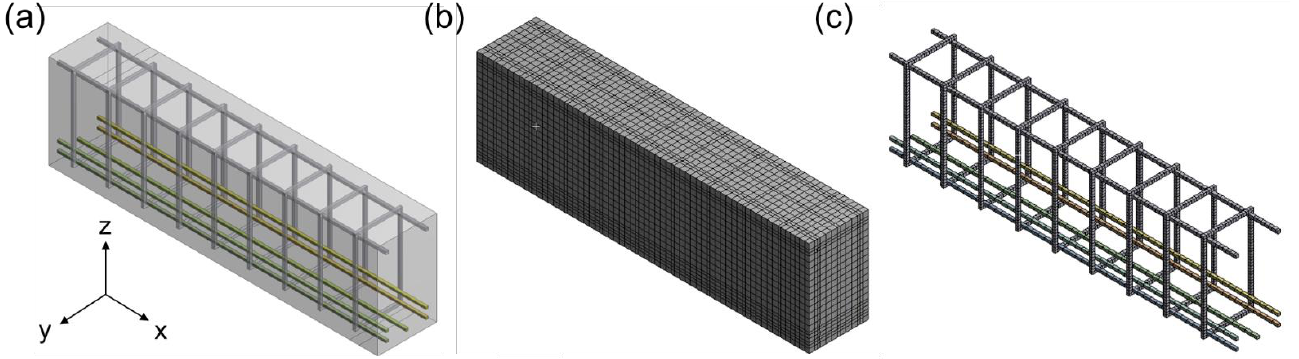
Figure 3. Representative geometry and FE meshes of the numerical model, shown for the RC beam model with 5 Fe-SMA bars. ( a ) Geometry of the FE model used in the study for RC beam with 5 SMA bars and FE meshes for ( b ) concrete and ( c ) SMA bars and rebars.